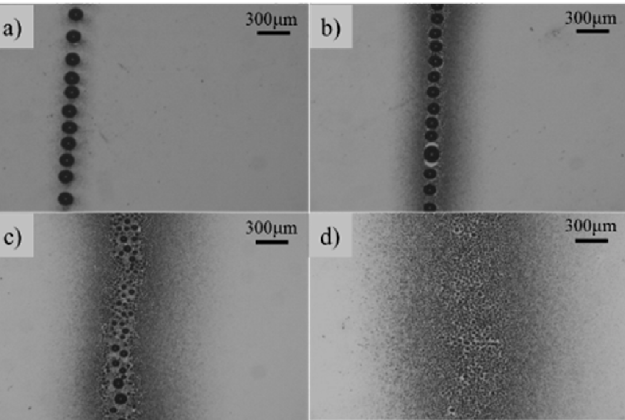
Figure 3. Electrosprayed patterns generated using the steel nozzle at a nozzle-to-substrate distance of ( a ) 1 mm, ( b ) 3 mm, ( c ) 5 mm, and ( d ) 5 mm. The flow rate was 50 μ L/h for ( a – c ) and 100 μ L/h for ( d ). The applied voltage was 3 kV.